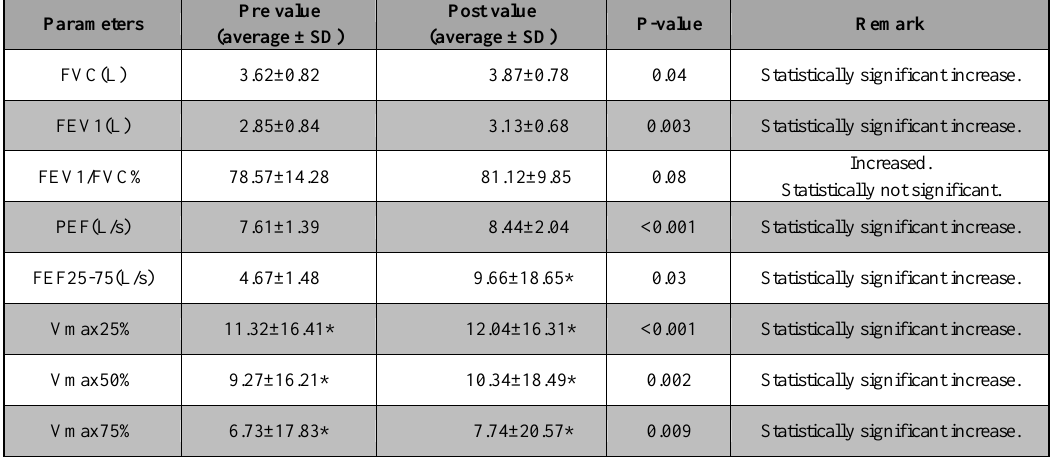
Table 3. PFT values in study group subjects before and after mudra